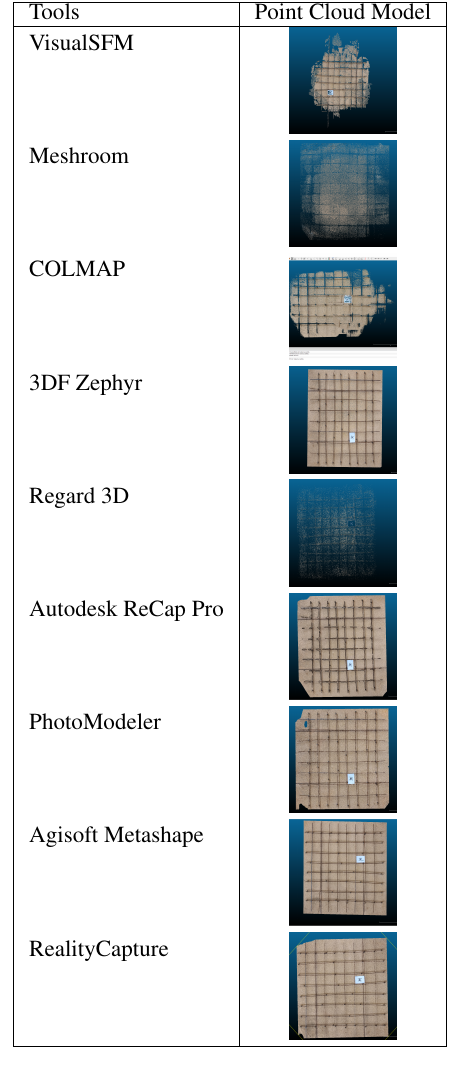
Table 3. Generated 3D point cloud models.